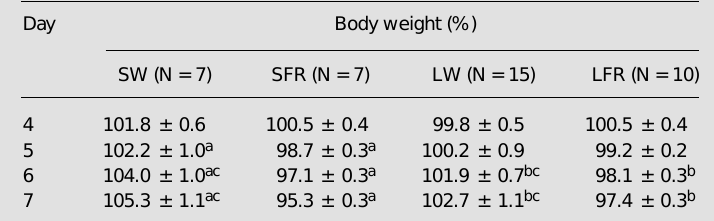
Table 2 - Body weight (%) from the fourth to the seventh day after tumor cell inoculation in sham-operated tumor-bearing (SW; N = 7) and septal-lesioned tumor-bearing (LW; N = 15) rats.